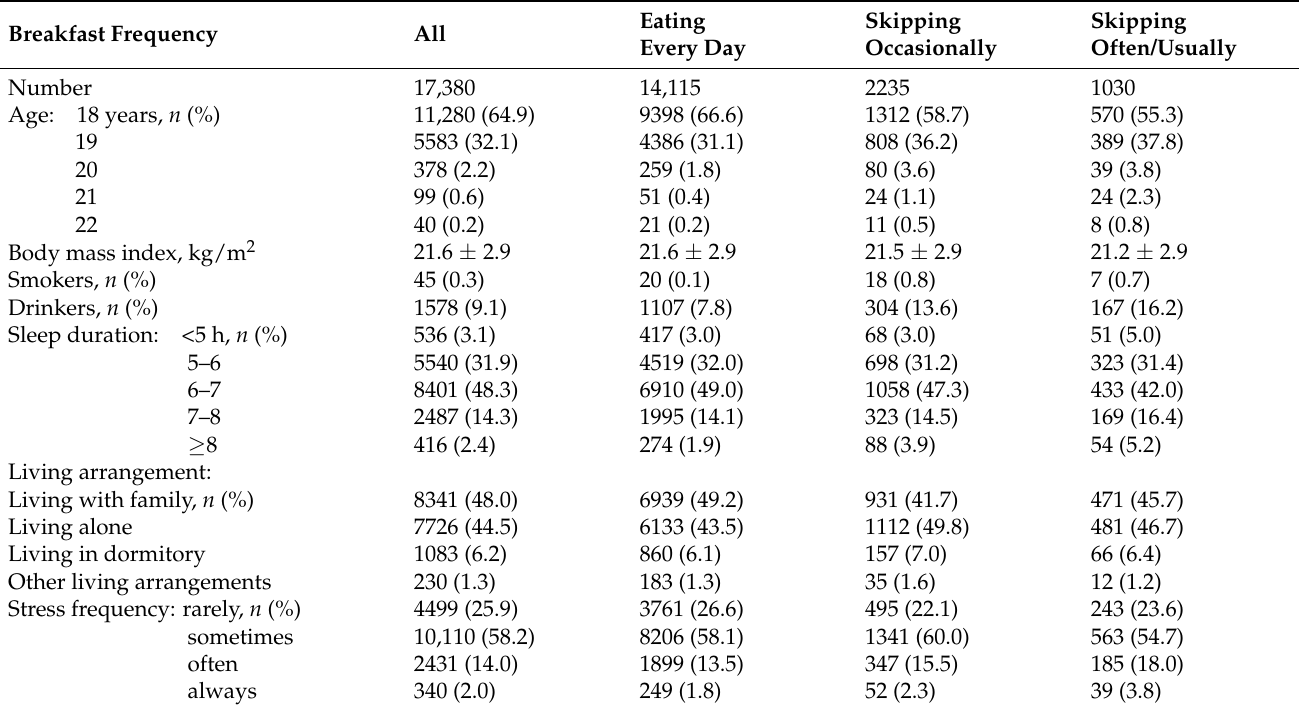
Table 1. Baseline characteristics of 17,380 male university students stratified by breakfast frequency.